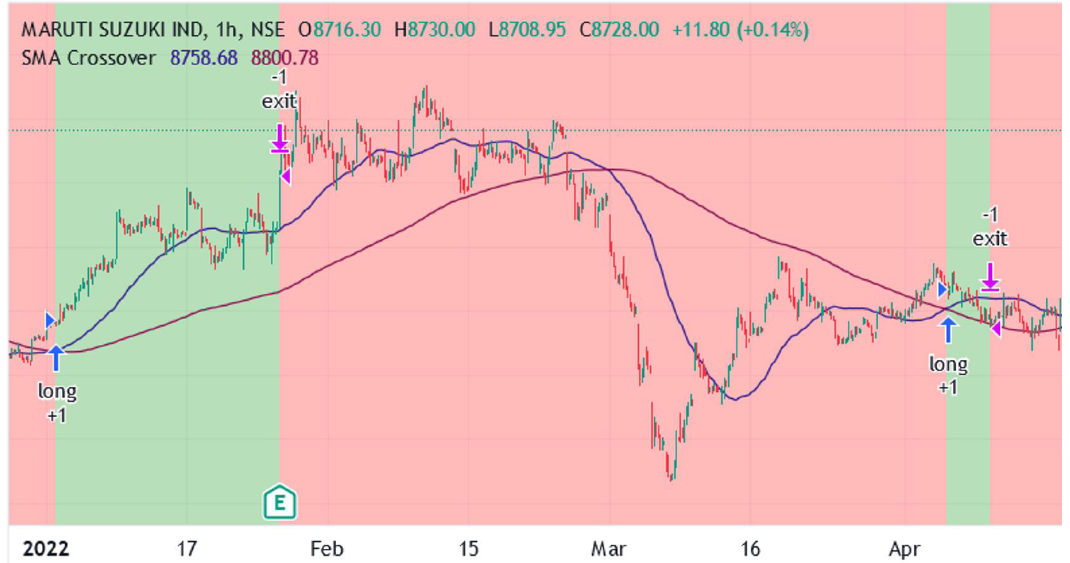
Figure 2. SMA Crossover Strategy applied on Maruti Suzuki